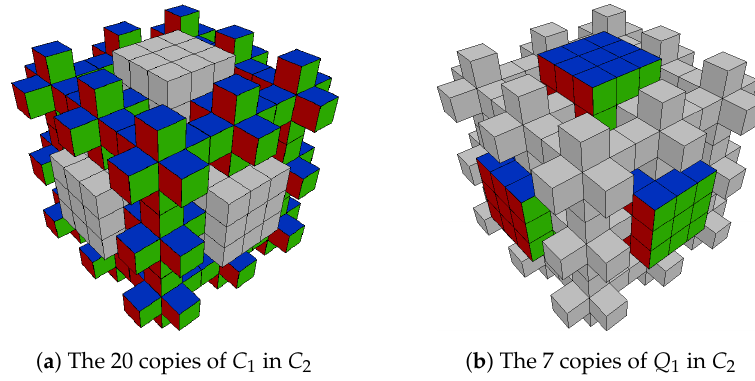
Figure 10. C 2 as a polycube composed of copies of C 1 and of Q 1